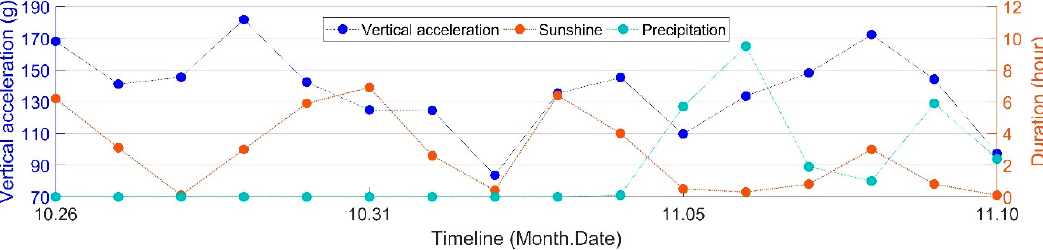
Figure 11. Development of vertical acceleration together with the durations of sunshine and precipitation.